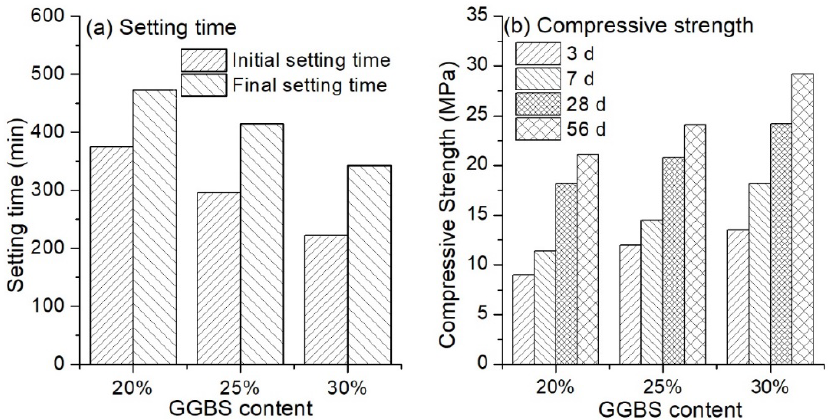
Figure 6. Setting time ( a ) and compressive strength ( b ) of alkali activated LFA-GGBS hybrid binder with different GGBS content (Na 2 O content 10%, n = 1.4, and w/s =